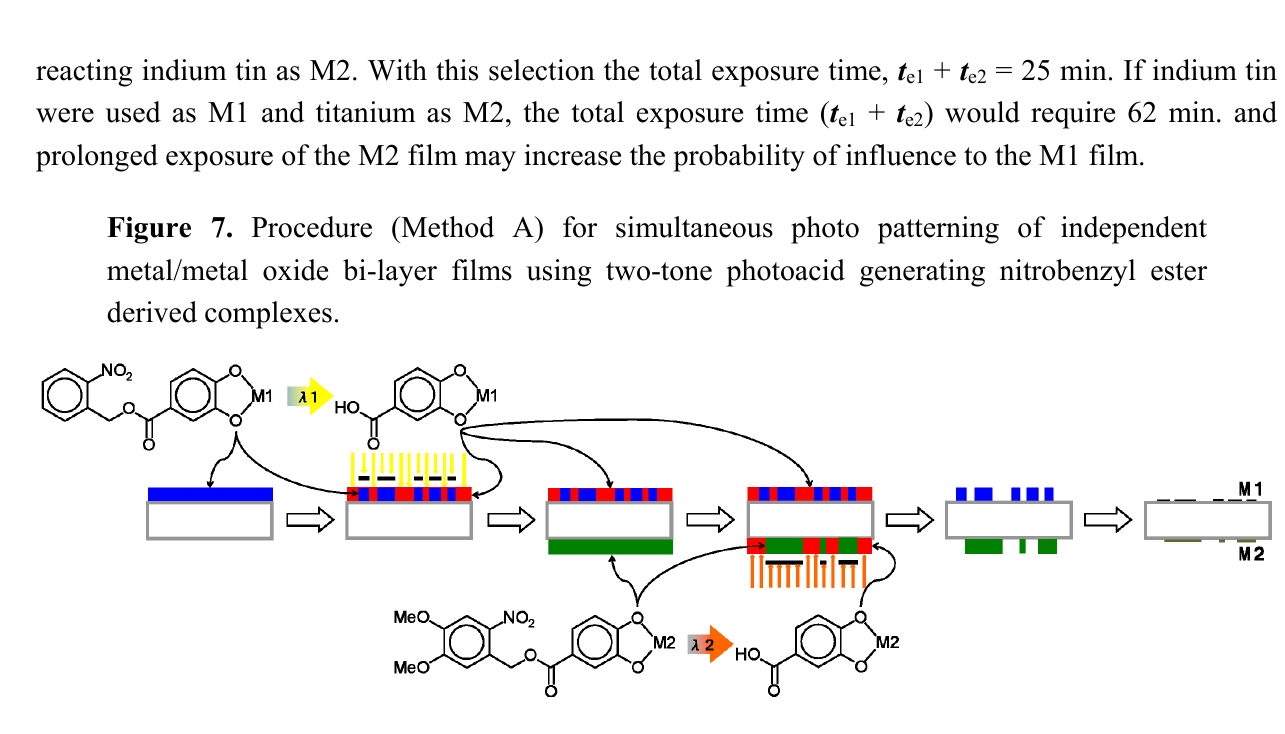
Figure 8. Procedure (Method B) for simultaneous photo patterning of independent metal/metal oxide bi-layer films using two-tone photoacid generating nitrobenzyl ester derived